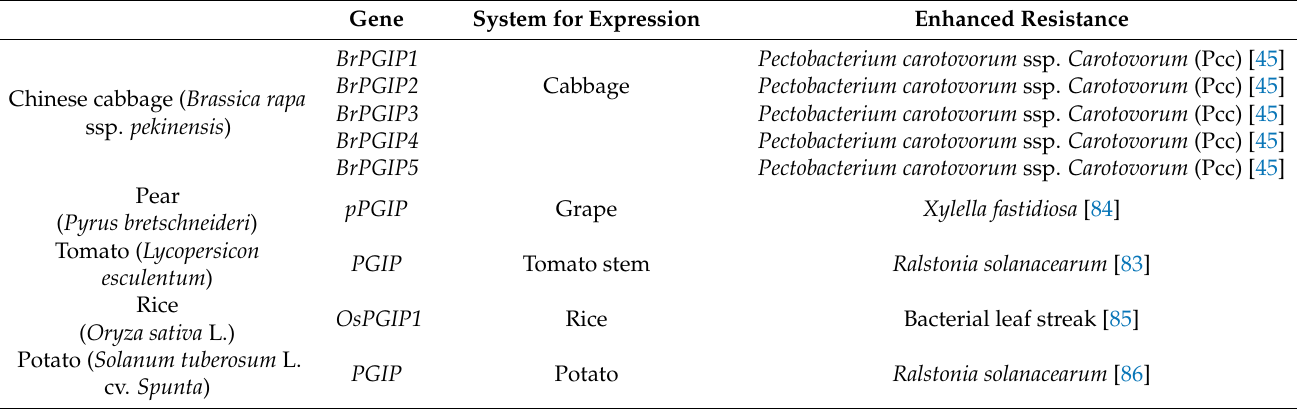
Table 3. PGIP genes studied in various systems against bacterial stresses. Gene System for